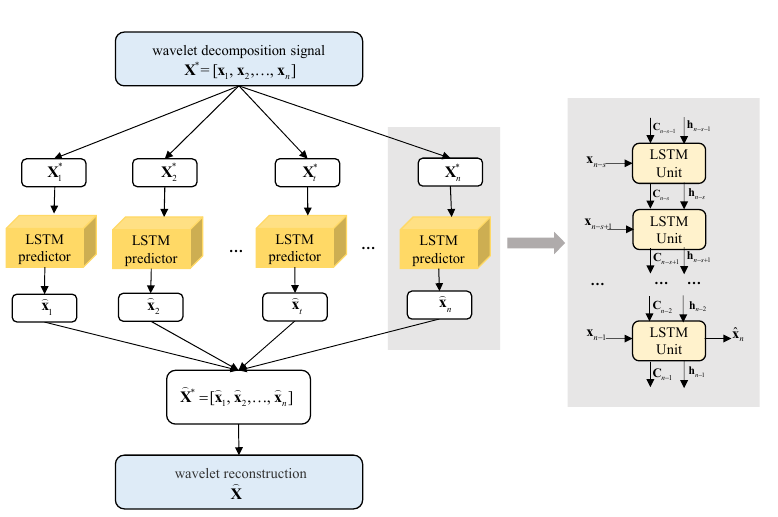
Figure 3. Structure of the